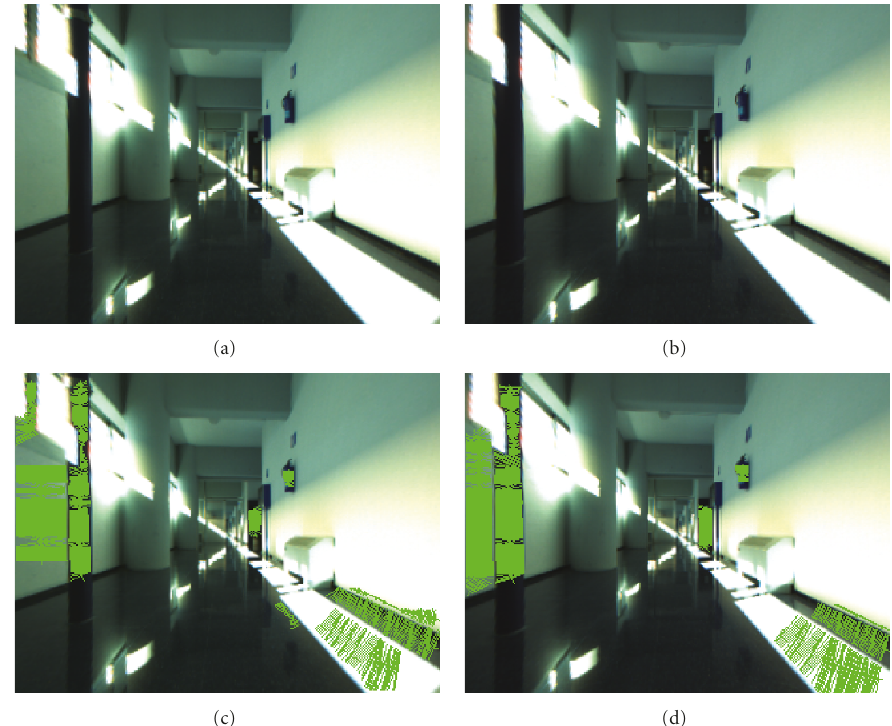
Figure 11: Consecutively acquired images by the Pioneer robot, with size 320 × 240 pixels. (a)-(b) Original images. (c)-(d) Original images with the results of the detection superimposed. Several landmarks are detected in both of the